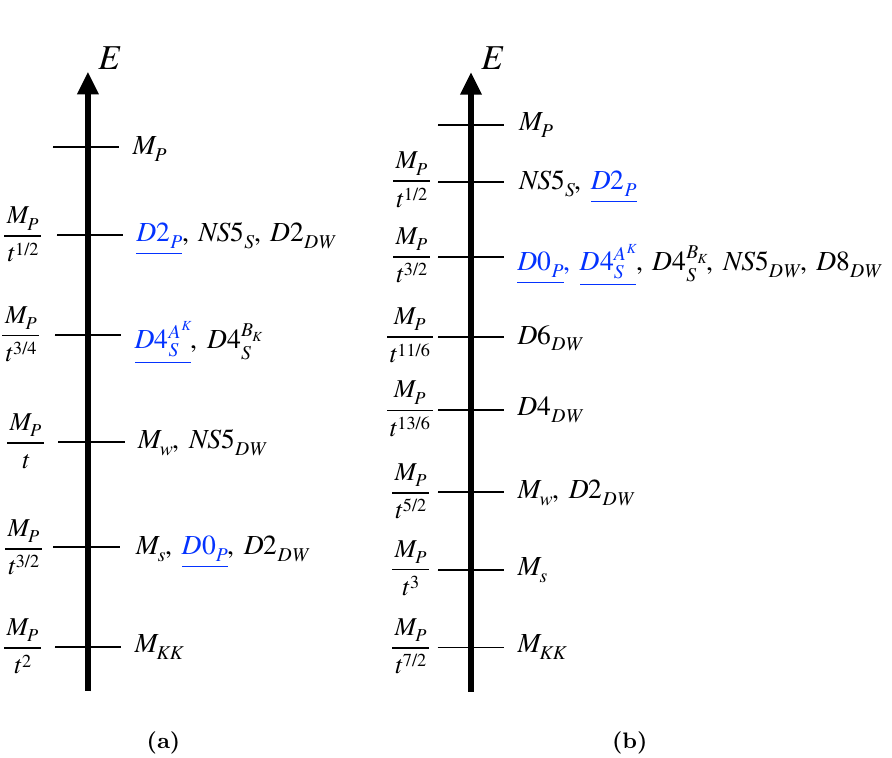
Figure 2. Energy scales associated to the 4d particles, strings and domain walls that become massless/tensionless and remain within the perturbative regime as we approach the in(cid:12)nite distance points given by (a) s / u / t 3 = 2 ! 1 and (b) s / u / t 3 ! 1 . The string, KK and winding scales are also included. The subindices P , S and DW indicate whether the object is a particle, a string or a domain wall and the ones in blue and underlined are projected out by the orientifold